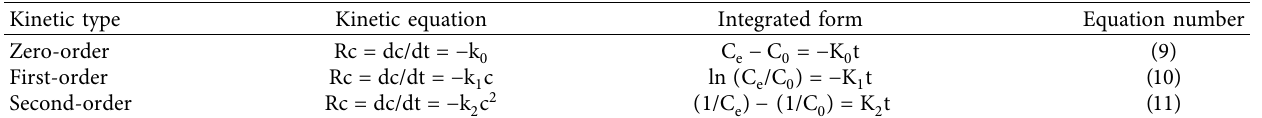
Figure 7: Te efect of scavengers on the rate of atenolol removal. Table 3: Kinetic equations for ATN